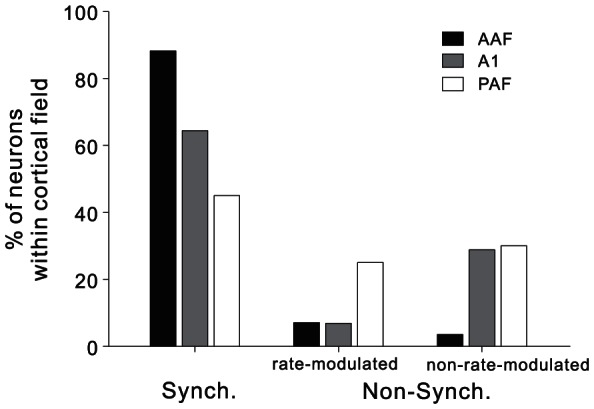
Comparison of the proportion of different types of neurons in AAF, A1 and PAF.